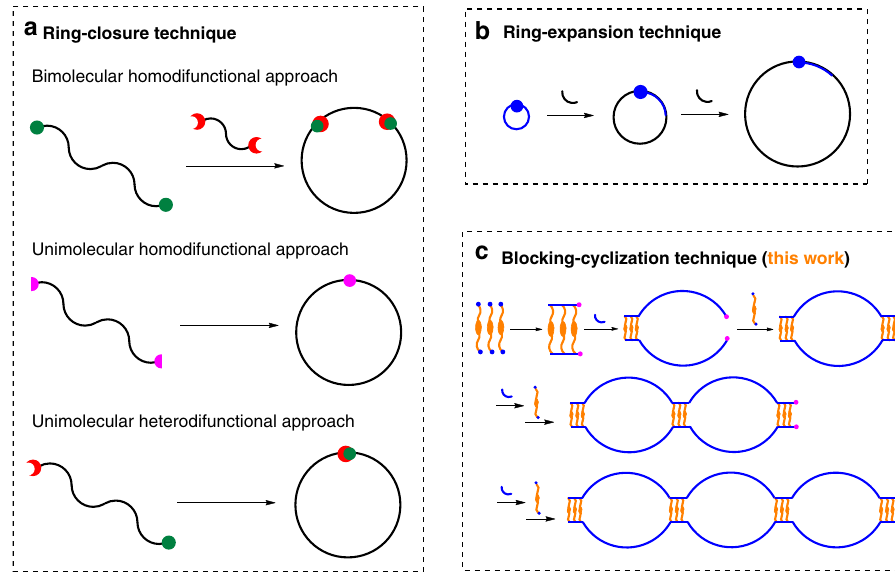
Fig. 1 Schematic representation of different techniques for the preparation of cyclic polymers. a Ring-closure. b Ring-expansion. c